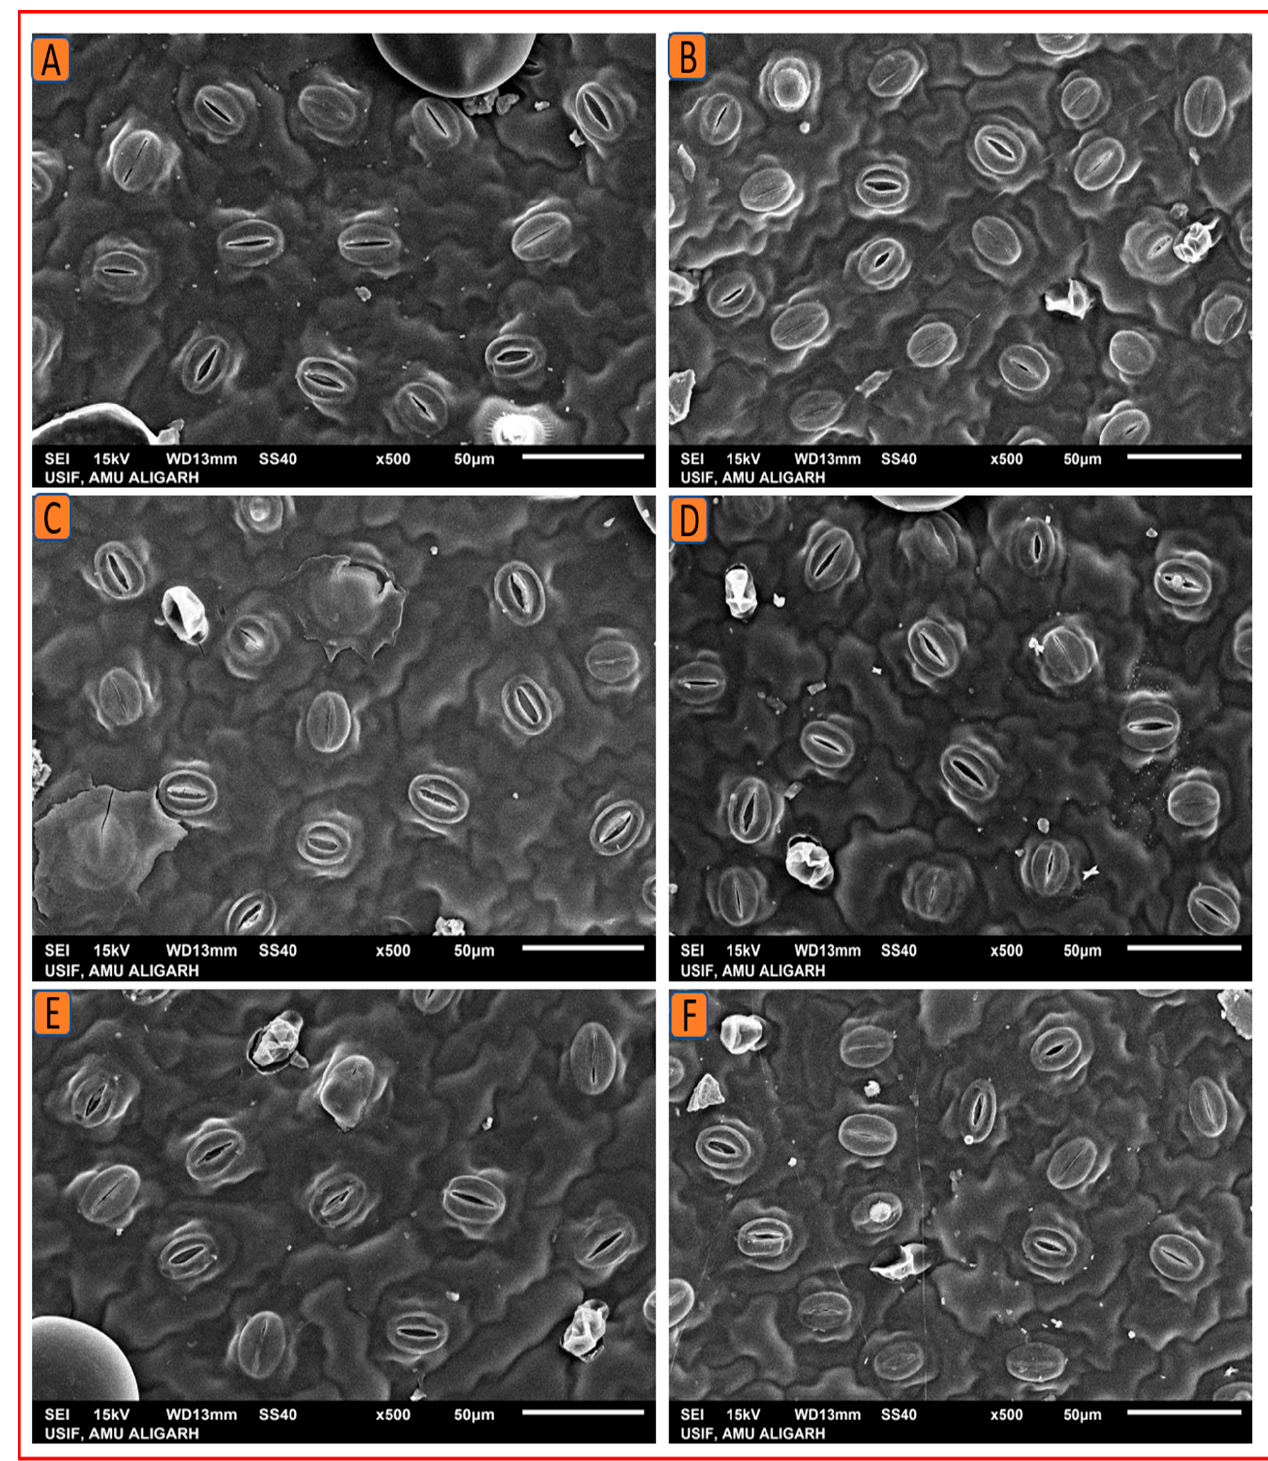
Figure 10. SEM micrographs depicting the stomatal density of the three peppermint cultivars studied. ( A ) Stomatal aperture density at 0% N in Kukrail, ( B ) at 1.5% N in Kukrail, ( C ) at 0% N in Pranjal, ( D ) at 1.5% N in Pranjal, ( E ) at 0% N in Tushar, ( F ) at 1.5% N in Tushar.